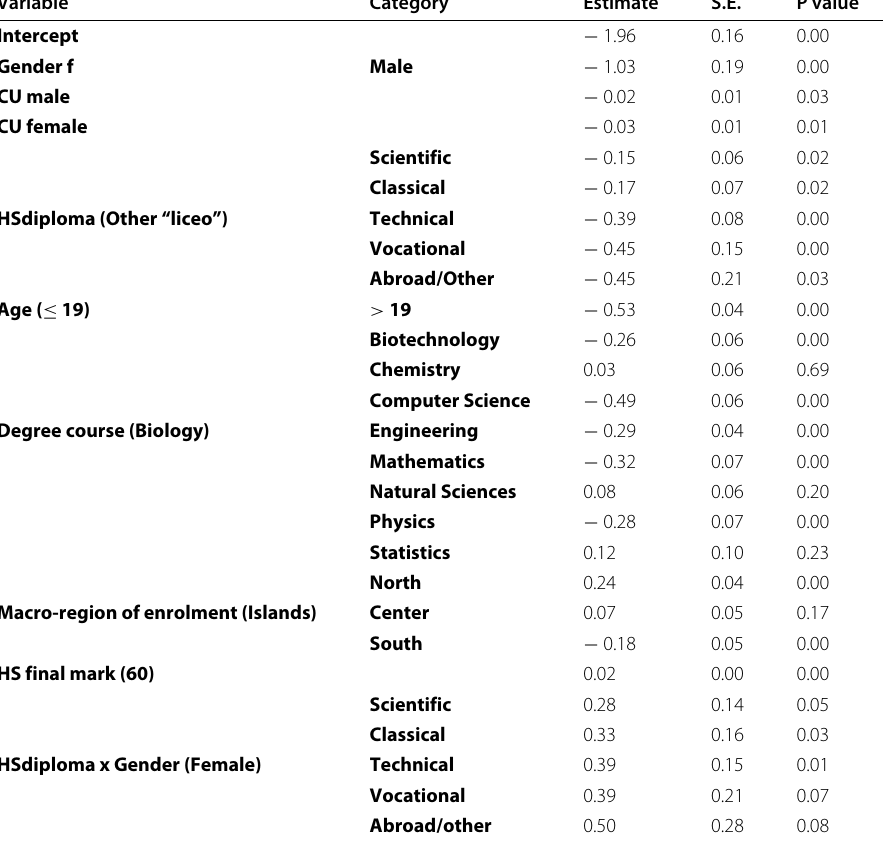
Table 2 Parameter estimates θ ’s of the segmented regression model in Eq. 4 Variable